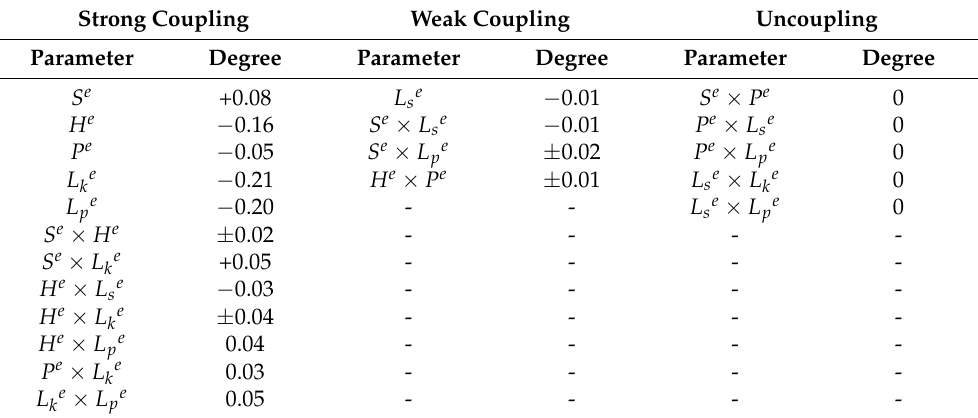
Table 7. Electromechanical coupling parameter identification of flexible interconnection.